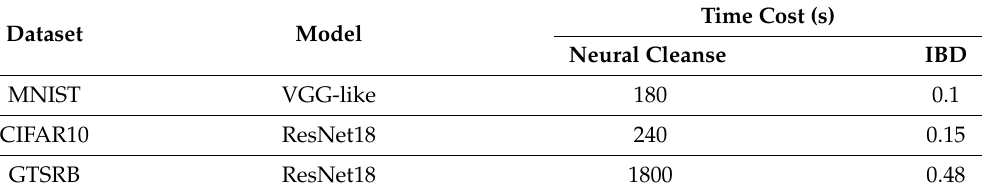
Table 3. Time cost comparison of Neural Cleanse and